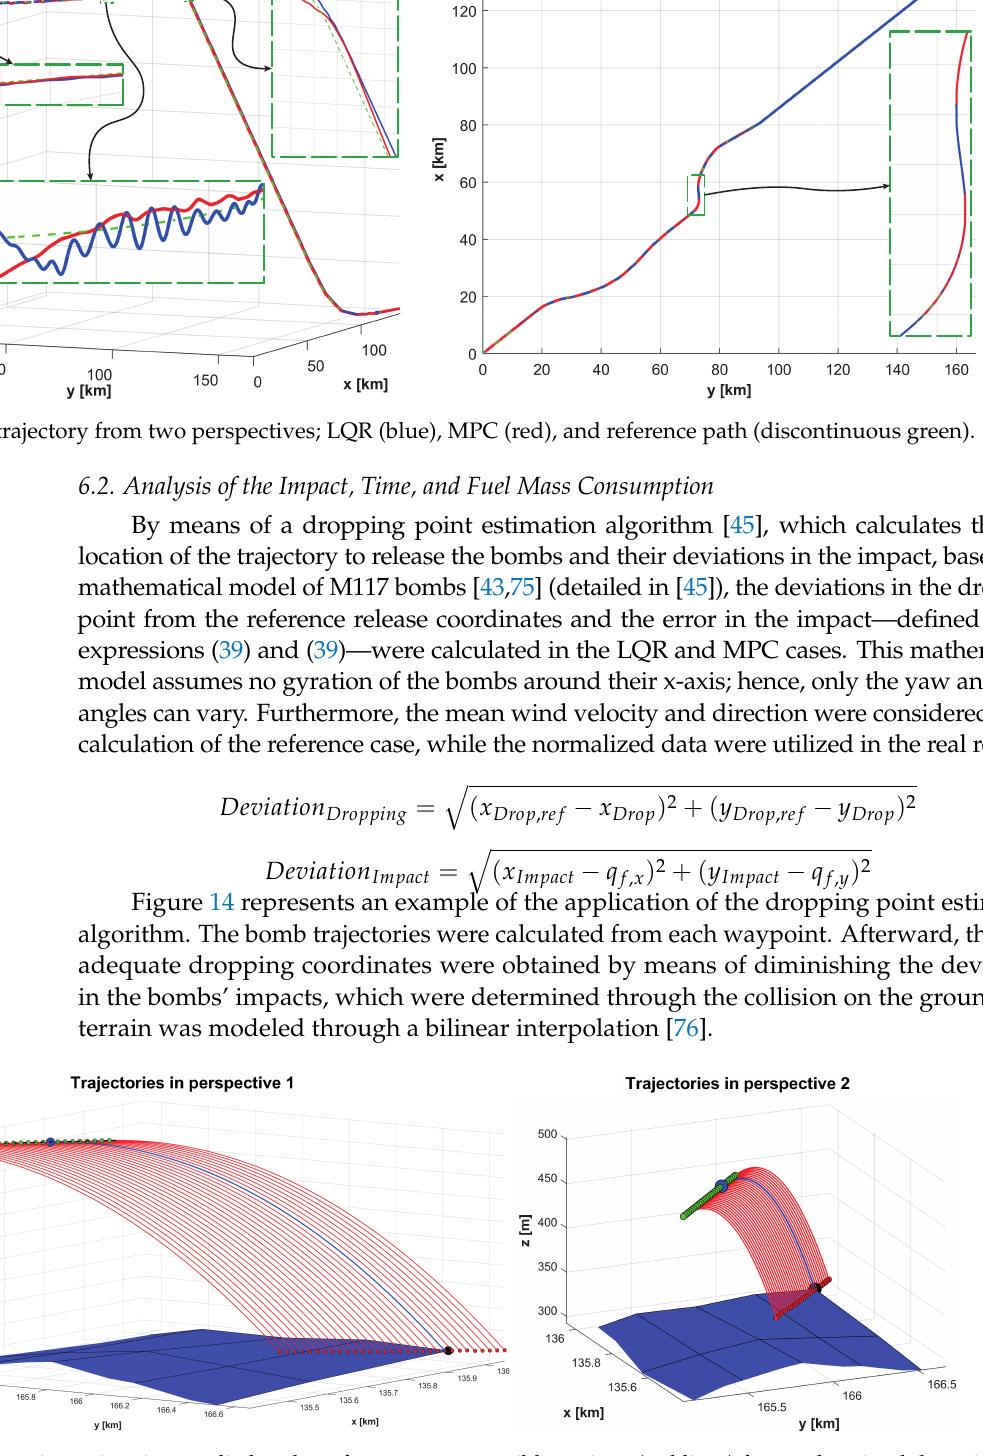
Figure 14. Dropping point estimation applied at the reference case: possible options (red lines) from suboptimal dropping points (green dots) and most appropriate option (blue line) from optimal release point (blue